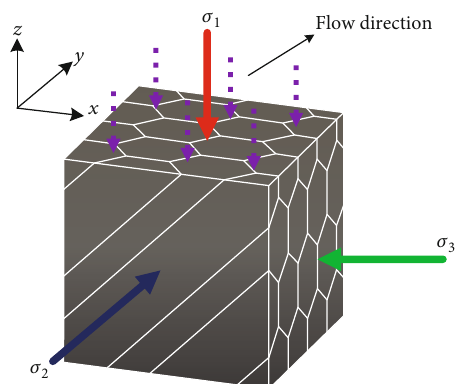
Figure 5: The schematic diagram of stress and hydraulic